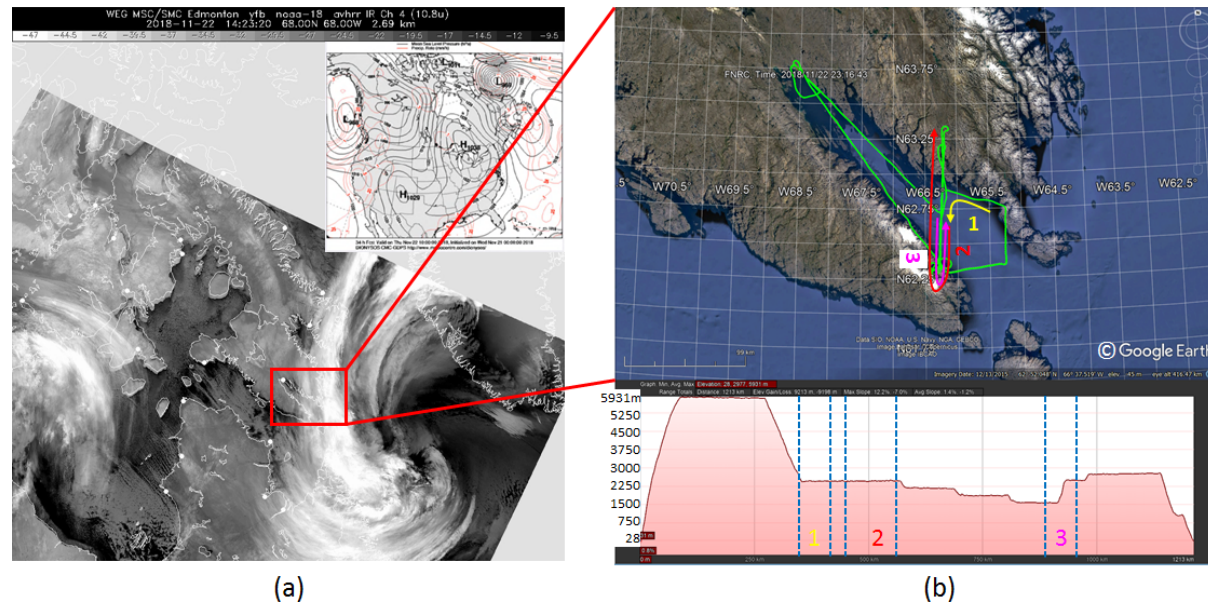
Figure 6. (a) NOAA-13 10.3µm channel AVHRR imagery showing the Arctic storm. (b) The Convair flight track (green) and altitude plot on 22 November. Locations of three legs used for the case studies in this flight are marked with different colors (yellow, red, and magenta).